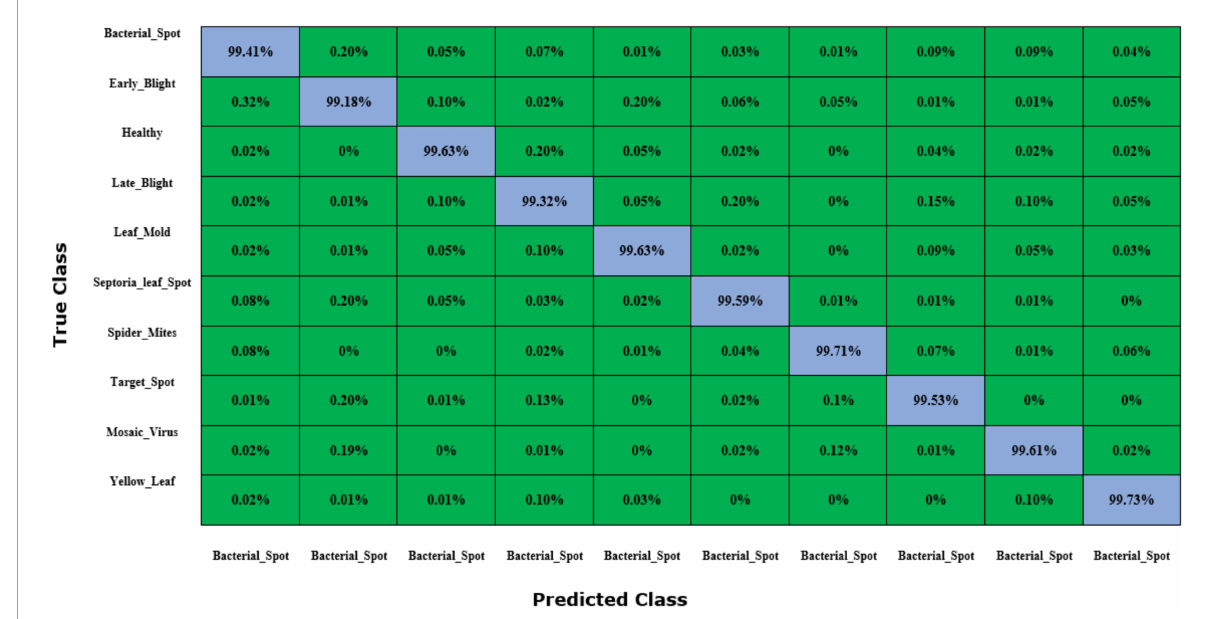
FIGURE12 Confusion matrix results for tomato plant leaf diseases classification obtained using the DenseNet-77-based CornerNet